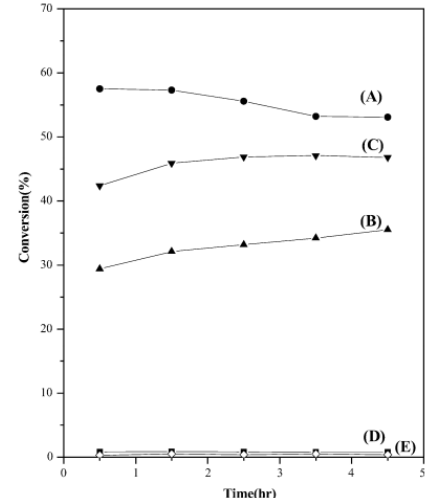
Figure 8. CO conversion of the calcined mesoporous silica containing Au-NPs: ( A ) MCM-41; ( B ) MCM-48; ( C ) SBA-15; ( D ) uncalcined MCM-41 and ( E ) Au/MCM-41 prepared by Dp. Reaction conditions: feed gas: 1 wt.% CO balanced with air, T = 80 °C and WHSV = 9 × 10 4 mL h − 1 g − 1 . Reproduced with permission from [36]. Copyright 2005